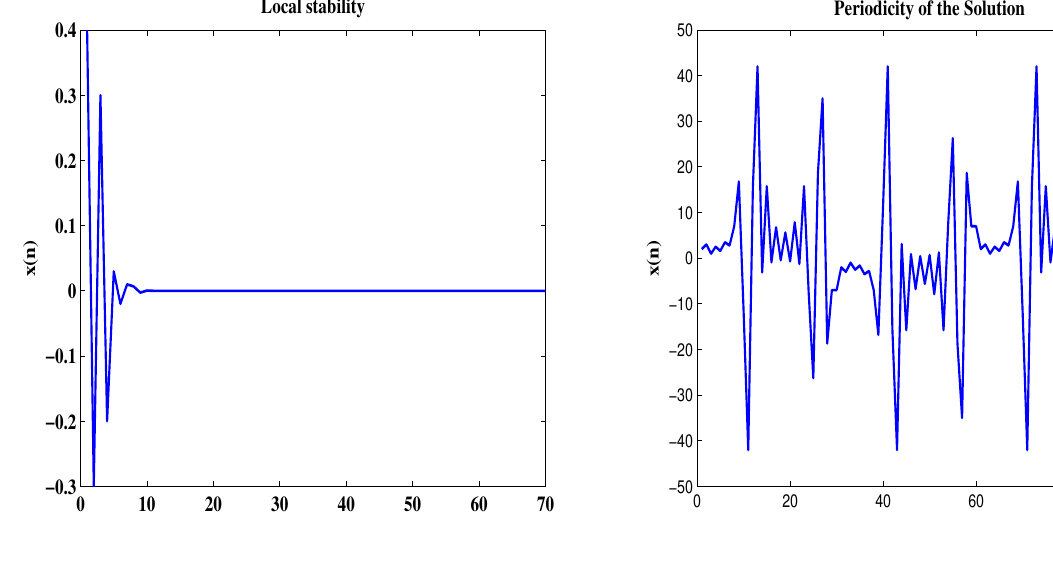
Figure 3: The Periodicity of Eq. (12) .